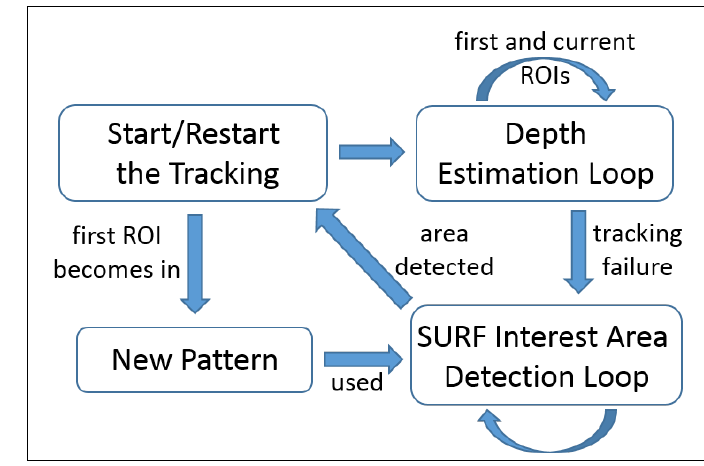
Figure 15. Recovering System